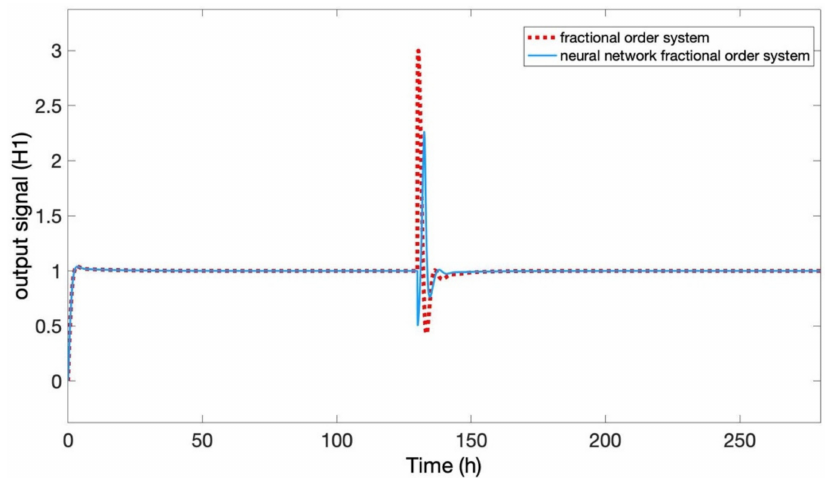
Figure 13. The proof of the proposed adaptive solution when a disturbance implies the β variation from 1.45 to 1.15 at t = 130 ( h )